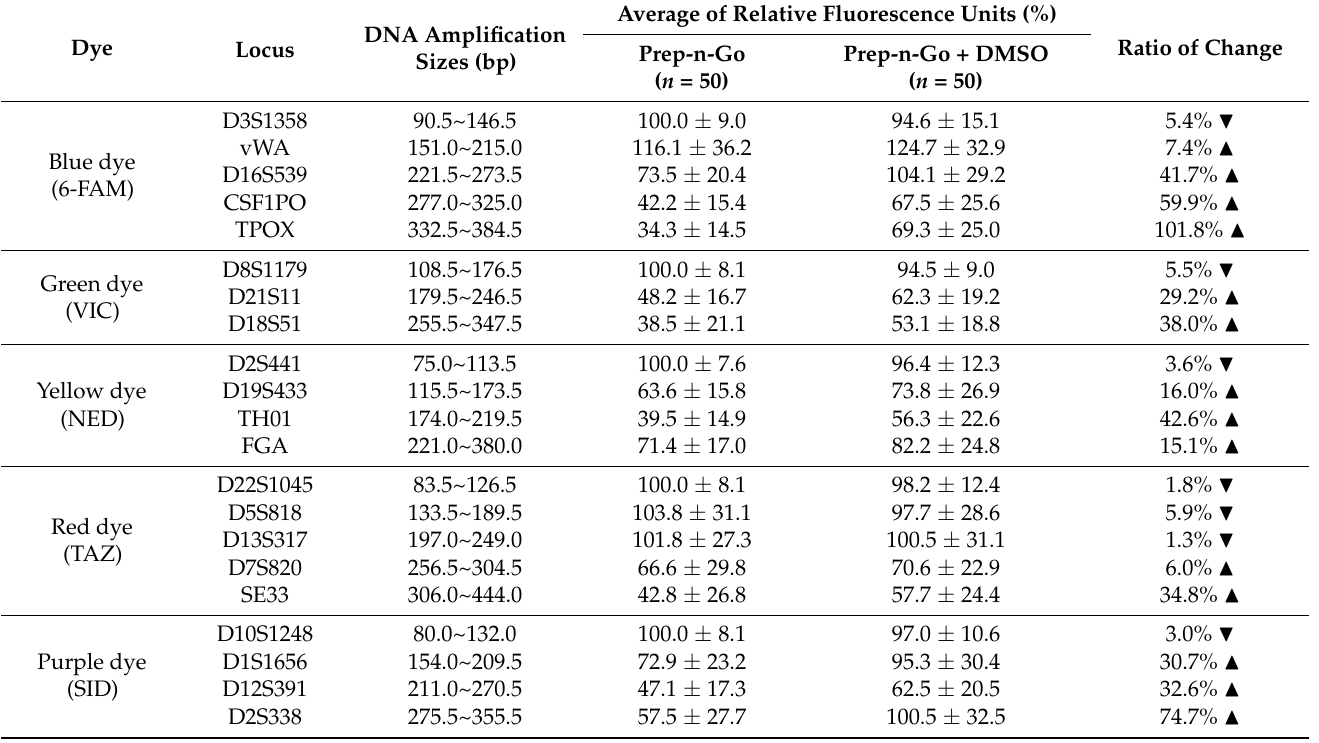
Table 1. Dimethyl sulfoxide (DMSO) improved the relative fluorescence unit (RFU) ratio of short tandem repeat (STR) genotyping in each color